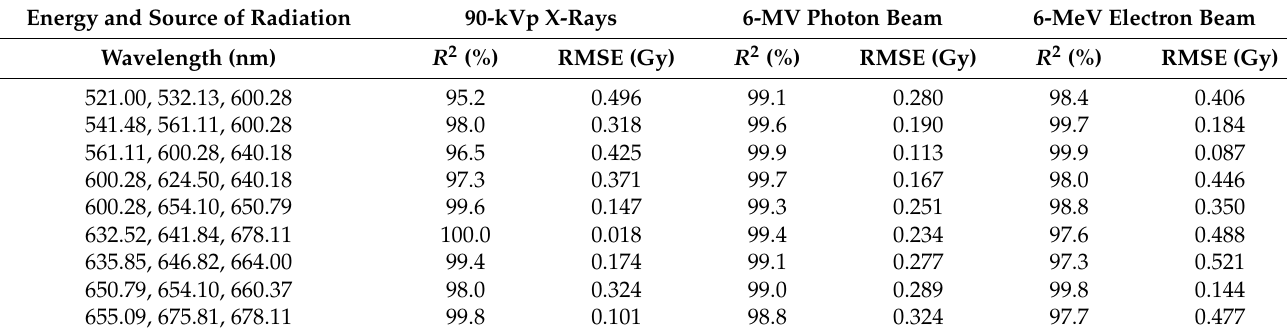
Table 3. Results of Multiple Linear Regression Technique using the selected wavelengths. Energy and Source of Radiation 90-kVp X-Rays 6-MV Photon Beam 6-MeV Electron